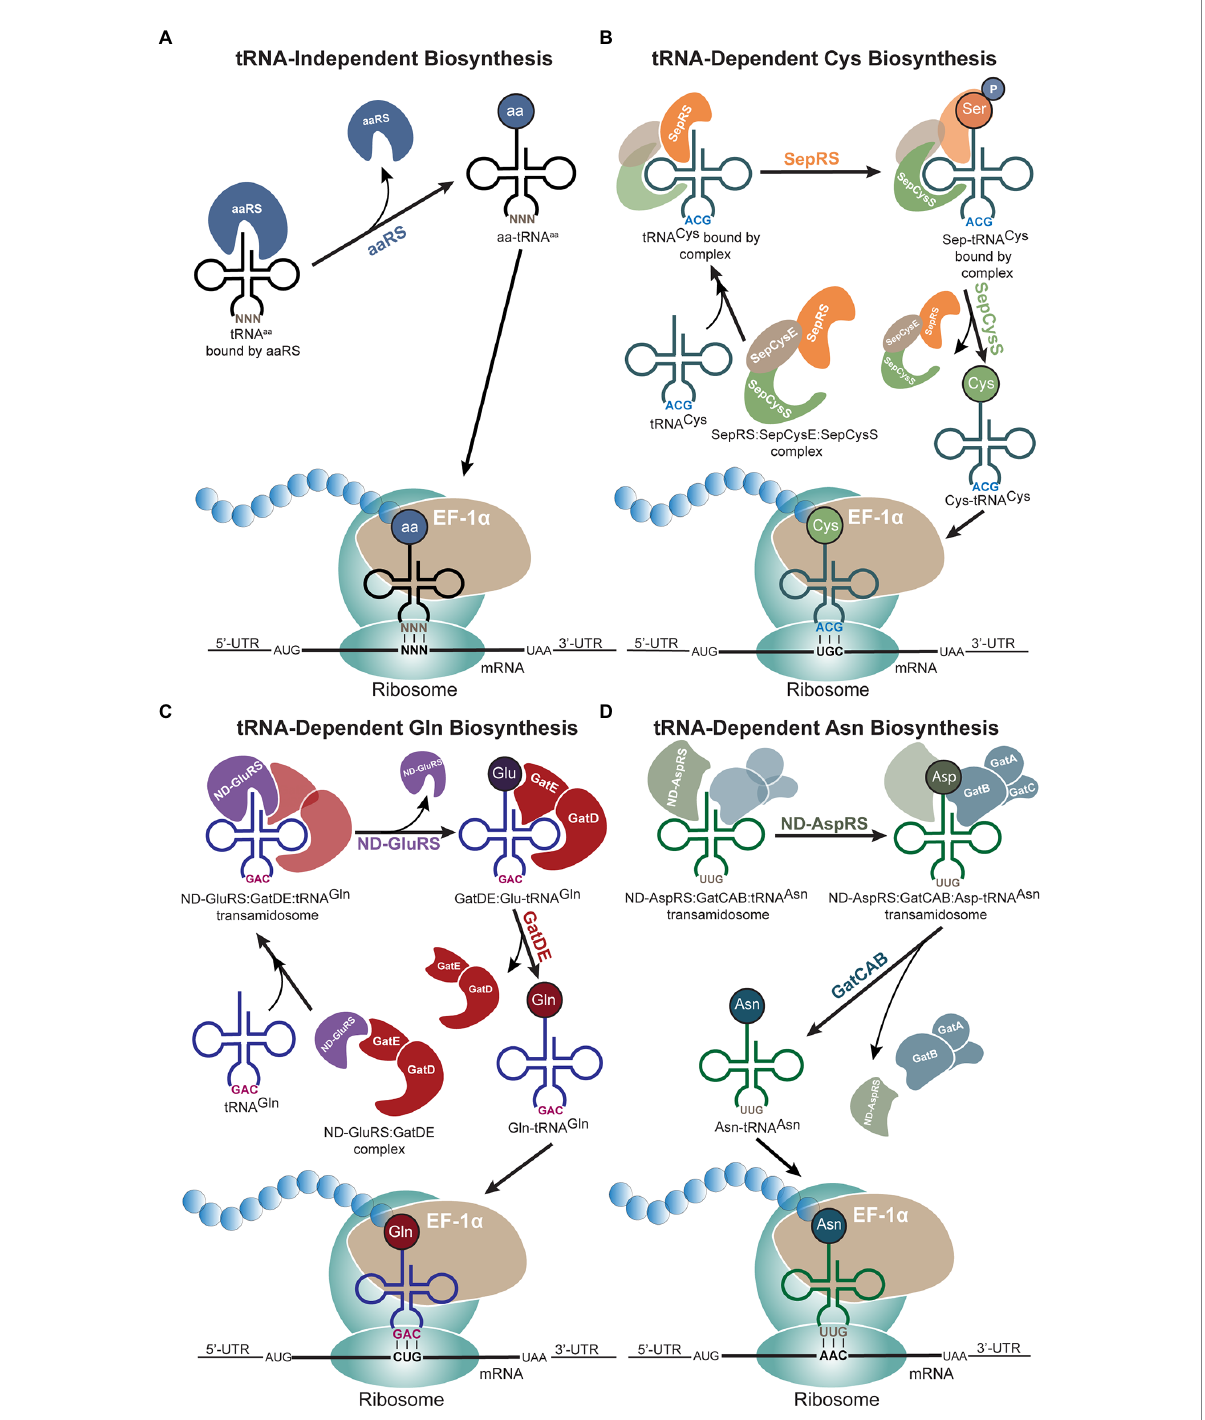
FIGURE 4 tRNA-dependent biosynthesis of amino acids in archaea. (A) Schematic of the traditional tRNA-independent biosynthesis of amino acids, (B) cysteine (Cys), (C) glutamine (Gln), and (D) asparagine (Asn) proceed through different mechanisms. (B) Protein complex formation precedes binding of tRNA Cys . The two-step process of Cys biosynthesis occurs through O -phosphoseryl-tRNA synthetase (SepRS) and SepCysS, while the protein-tRNA Cys complex remains intact until phosphoseryl is converted to Cys. (C) tRNA-dependent Gln biosynthesis also begins with protein complex formation followed by binding of tRNA Gln . After non-discriminating glutamyl-tRNA synthetase (ND-GluRS) aminoacylates tRNA Gln with glutamic acid (Glu), ND-GluRS dissociates for the GatDE heterodimer to catalyze the conversion of Glu to Gln. (D) Non-discriminating aspartyl- tRNA synthetase (ND-AspRS) and GatCAB form a complex through binding tRNA Asn . This complex remains intact even after ND-AspRS aminoacylates tRNA Asn with aspartic acid (Asp), and the complex only dissociates once GatCAB converts Asp to Asn. In all pathways, archaeal EF-1 α brings the aminoacyl-tRNAs (aa-tRNAs) to the